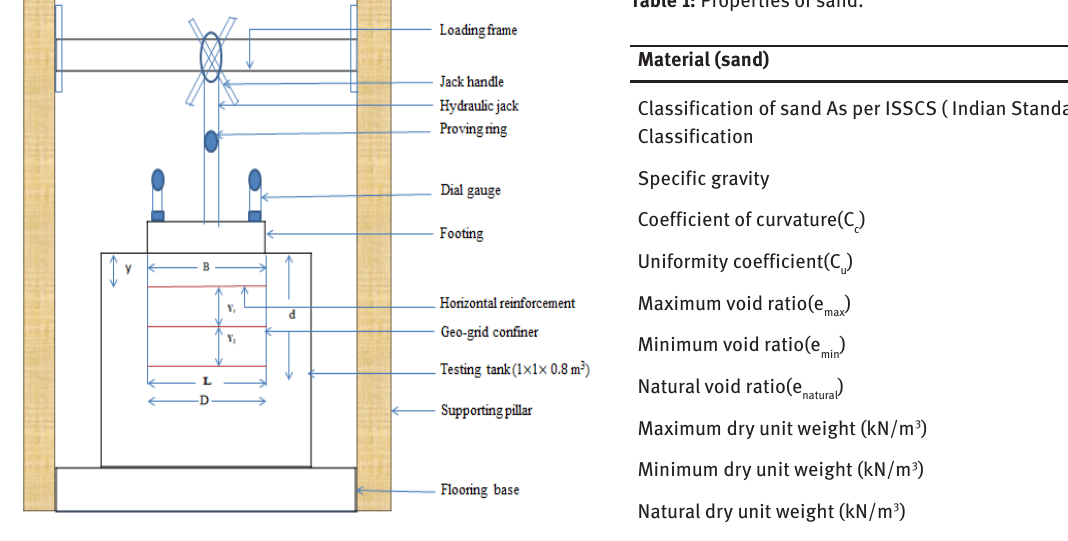
Figure 1: Schematic diagram of the experimental set up.